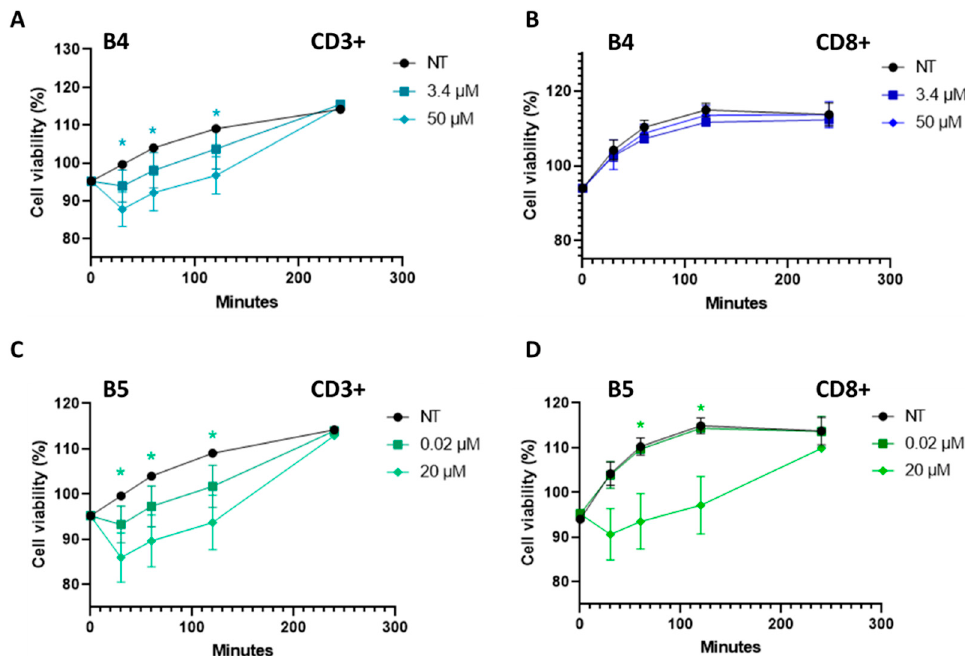
Figure 9. MTS time-kinetics viability assays of human normal primary CD3+ and CD8+ T-cells after B4 and B5 administration. ( A ) CD3+ T-cells viability after B4 treatment (3.4 and 50 µ M). Cyan asterisks indicate p < 0.05, ANOVA One-Way, in 50 µ M treated samples compared with non-treated (NT) cells at 30, 60 and 120 min. ( B ) CD8+ T-cells viability after B4 treatment (3.4 and 50 µ M). ( C ) CD3+ T-cells viability after B5 treatment (0.02 and 20 µ M). Green asterisks indicated p < 0.05, ANOVA One-Way, in B5 20 µ M compared with non-treated (NT) cells at 30, 60 and 120 min. ( D ) CD8+ T-cells viability after B5 treatment (0.02 and 20 µ M). Green asterisks indicated p < 0.05, ANOVA One-Way, in B5 20 µ M compared with non-treated (NT) cells at 60 and 120 min. All the experiments were performed on three independent biological replicates, using human naïve T-cells isolated from 3 normal subjects. Data are reported as mean ± SEM.